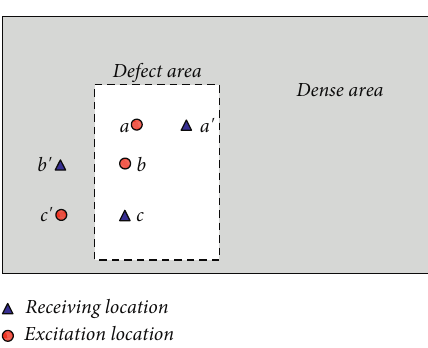
Figure 11: Excitation and reception